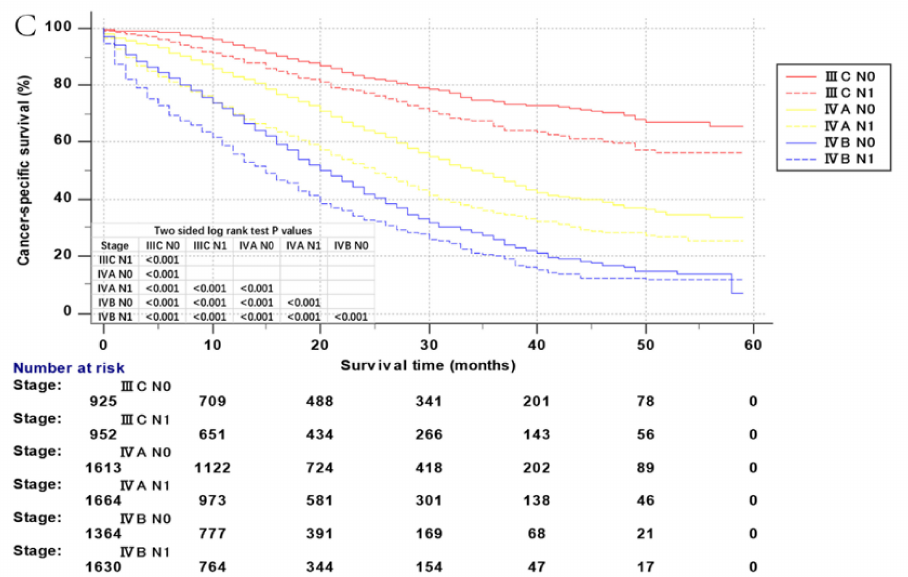
Figure 4. Kaplan–Meier survival curves of non-biological factor-Tumor-Node-Metastasis (NBF-TNM) staging system. ( A ) Cancer-specific survival (CSS) of I-N0 stage, I-N1 stage, IIA-N0 stage, IIA-N1 stage, IIIA-N0 stage, and IIIA-N1 stage. ( B ) CSS of IIB-N0 stage, IIB-N1 stage, IIC-N0 stage, IIC-N1 stage, IIIB-N0 stage, and IIIB-N1 stage. ( C ) CSS of IIIC-N0 stage, IIIC-N1 stage, IVA-N0 stage, IVA-N1 stage,